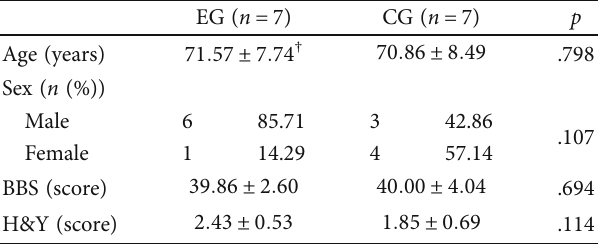
Table 3: General characteristics of the subjects ( N = 14